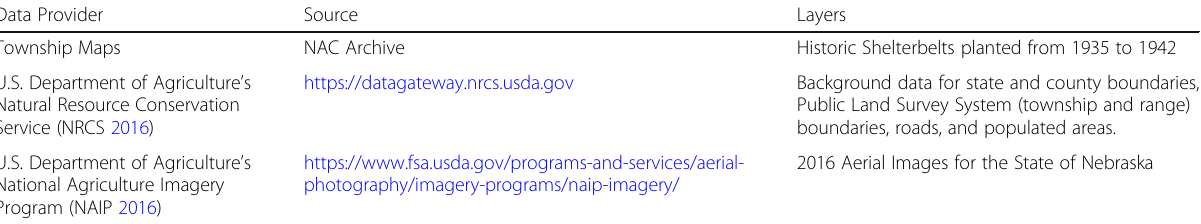
Table 1 Data provider, source, and spatial layers used in the study area of Nebraska